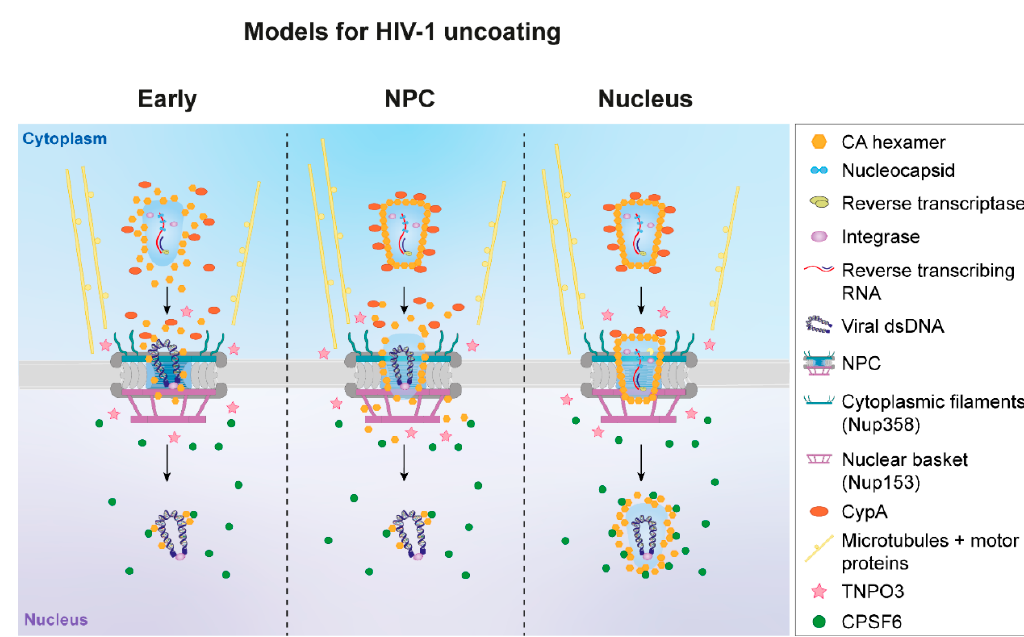
Figure 2. Models for HIV-1 uncoating. HIV-1 uncoating has been proposed to occur either early in the cytoplasm, at the NPC or after nuclear entry. The three possibilities are depicted, with host factors involved in uncoating and nuclear entry illustrated. Figure adapted from [57].